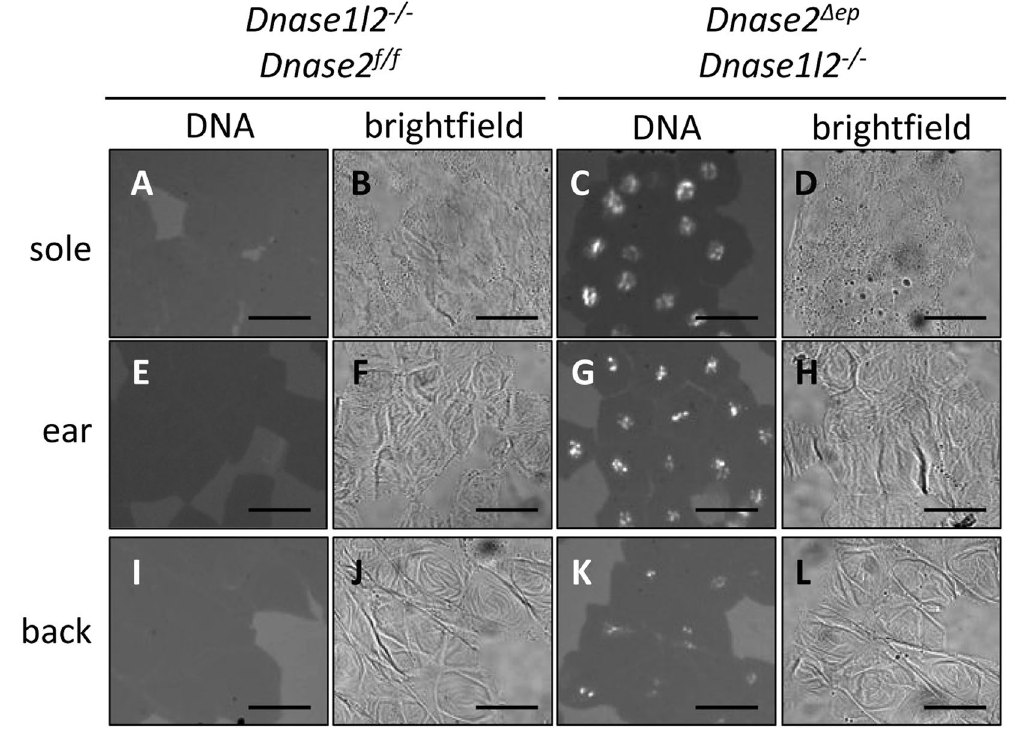
Figure 4. Isolated corneocytes of DNase1L2/DNase2-deficient mice retain DNA in a nucleus-shaped compartment. Corneocytes were isolated from the soles ( A–D ), ears ( E–H ), and back ( I – L ) of wild-type ( A , B , E,F , I , J ) and Dnase1l2 − / − Dnase2 Δ ep ( C , D , G,H , K , L ) mice. The corneocytes were incubated with DNA- specific dye Hoechst 33258 and fluorescence images in which white signals indicate the labeling (left panels) as well as bright-field images under phase contrast (right panels) were recorded. Scale bars, 20 µ m.